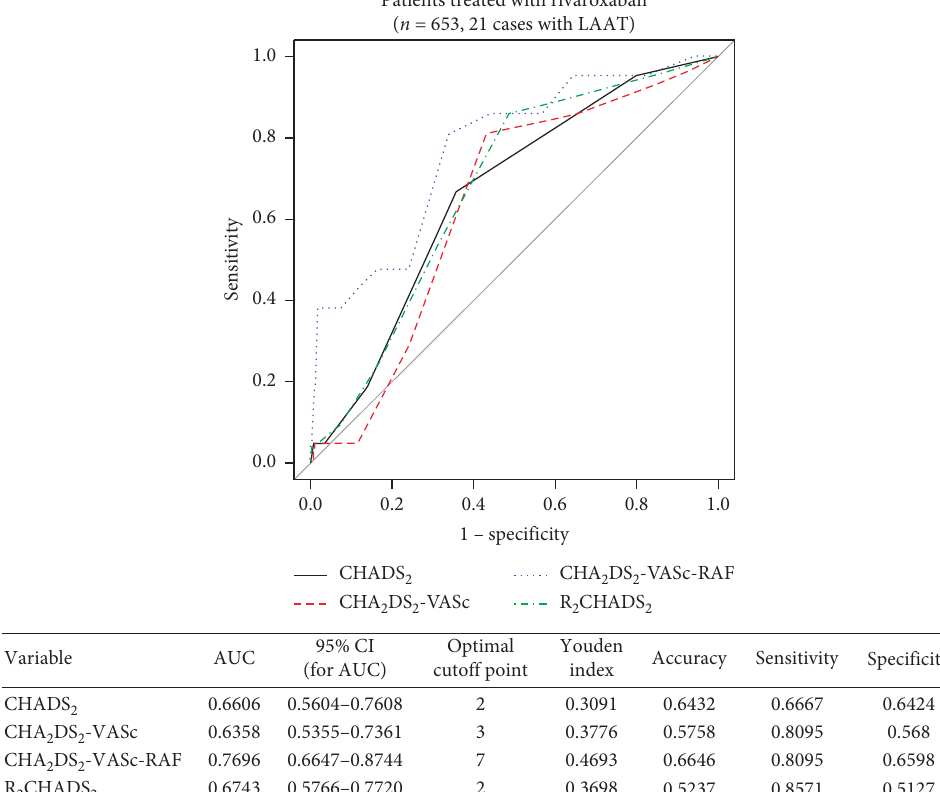
Figure 2: Receiver operating curves of CHADS 2 , CHA 2 DS 2 -VASc, CHA 2 DS 2 -VASc-RAF, and R 2 CHADS 2 for predicting LAAT and associated characteristics of that prediction in the rivaroxaban treatment